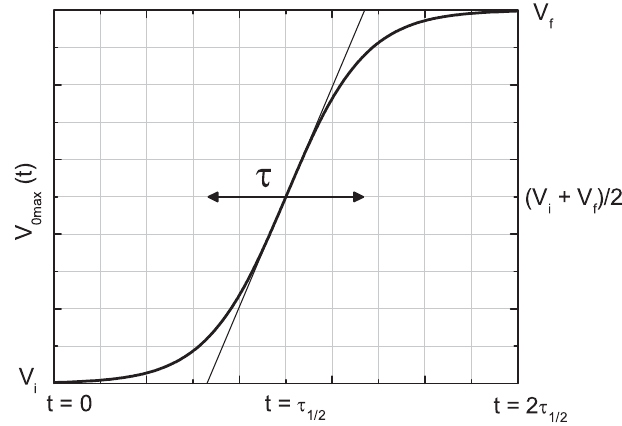
(cid:5) t (cid:6) used in 0max